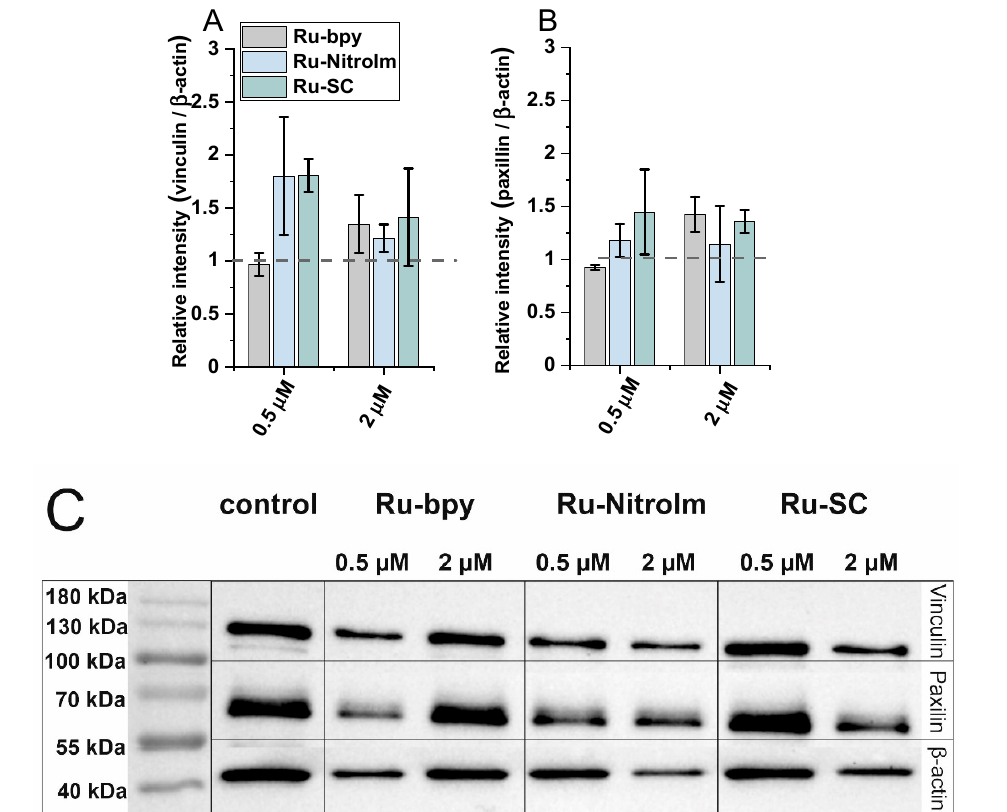
Figure 5. The expression levels of ( A ) vinculin and ( B ) paxillin measured by ( C ) western blot in HMEC-1 protein extracts obtained after 24 h of treatment with [Ru(dip) 2 (bpy)]Cl 2 (gray), [Ru(dip) 2 (bpy-nitro)]Cl 2 (blue) and Ru(dip) 2 (bpy-SC)]Cl 2 (green) (0.5 or 2 µ M). Expression for vinculin and paxillin were calculated with respect to β -actin.